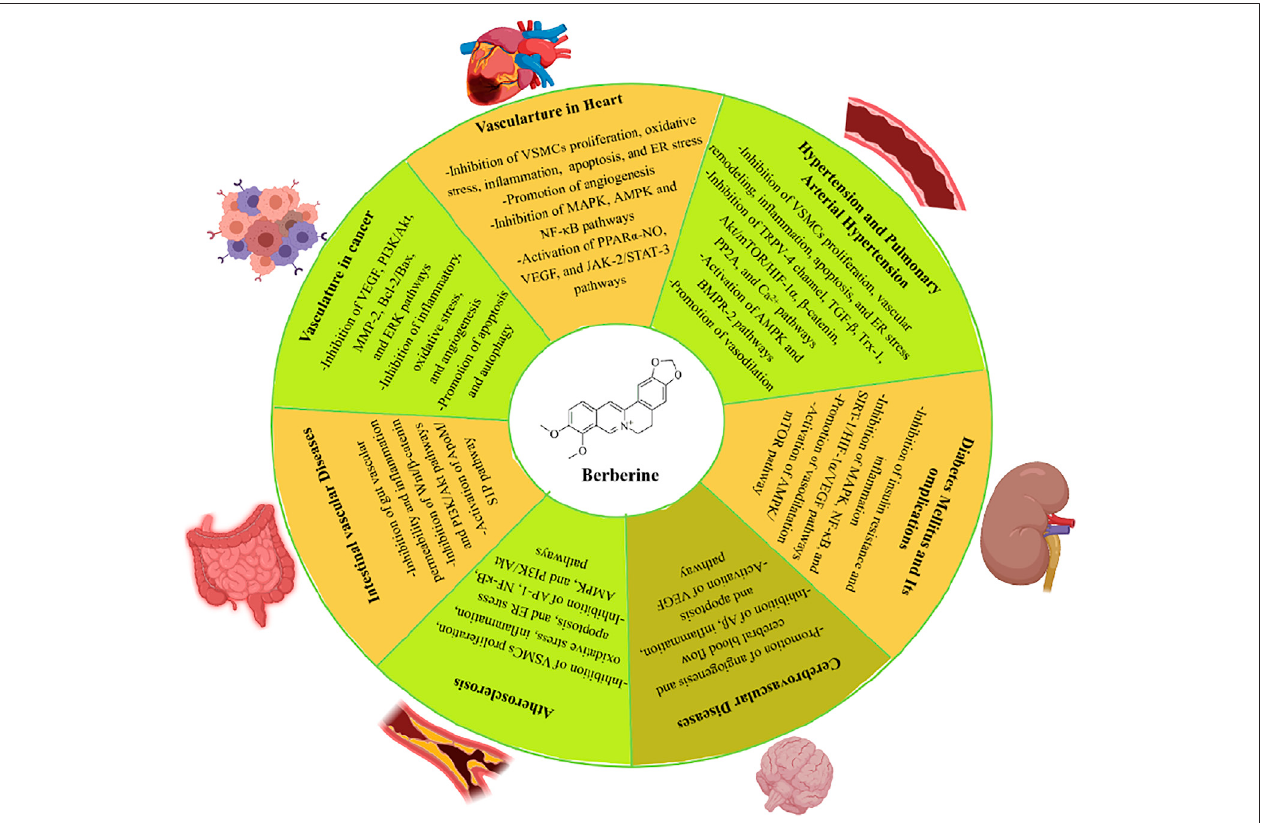
FIGURE 2 | Biological activities and potential pathways of berberine on vascular diseases. Abbreviations: Akt, protein kinase B; AMPK, AMP-activated protein kinase; AP-1, activator protein 1; Bax, Bcl-2 associated X protein; Bcl-2, B-cell lymphoma 2; BMPR-2, bone morphogenetic protein type 2; ER, endoplasmic reticulum; ERK, extracellular signal-regulated kinase; HIF-1 α , hypoxia-inducible factor 1 α ; JAK-2, janus kinase 2; MAPK, mitogen-activated protein kinase; MMP-2, matrix metalloprotease 2; NF- κ B, nuclear factor κ B; PI3K, phosphoinositide 3-kinase; SIRT-1, silent information regulator 1; STAT-3, signal transducer and activator of transcription3;TGF- β ,transforminggrowthfactor β ;TRPV-4,transientreceptorpotentialvanilloid4;VEGF,vascularendothelialgrowthfactor;VSMCs,vascularsmooth muscle